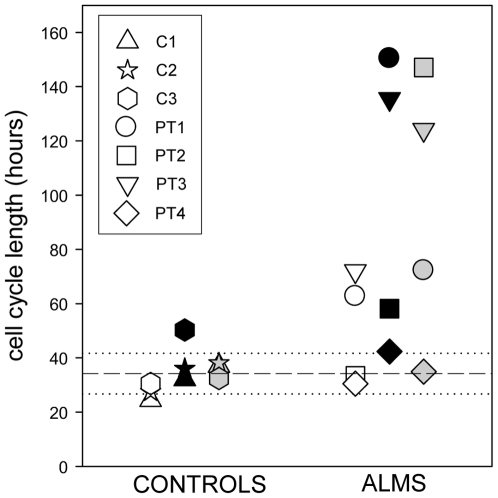
ALMS fibroblasts display a longer cell cycle than controls.Cell cycle length of control (C1–C3) and ALMS fibroblasts (PT1–PT4) was estimated by culture experiments in 10% FBS SM (white symbols), in 2% FBS SM (black symbols), and upon serum deprivation for 48 hour, followed by culture in 10% FBS SM (grey symbols) by comparing the number of viable cells at 0 hours and at 72 hours of culture, using CellTiter-Glo® Luminescent Cell Viability Assay (Promega). The short dash line indicates the mean value of cell cycle length of controls in all growth conditions analyzed, while the dotted lines represent the mean value ± one SD.